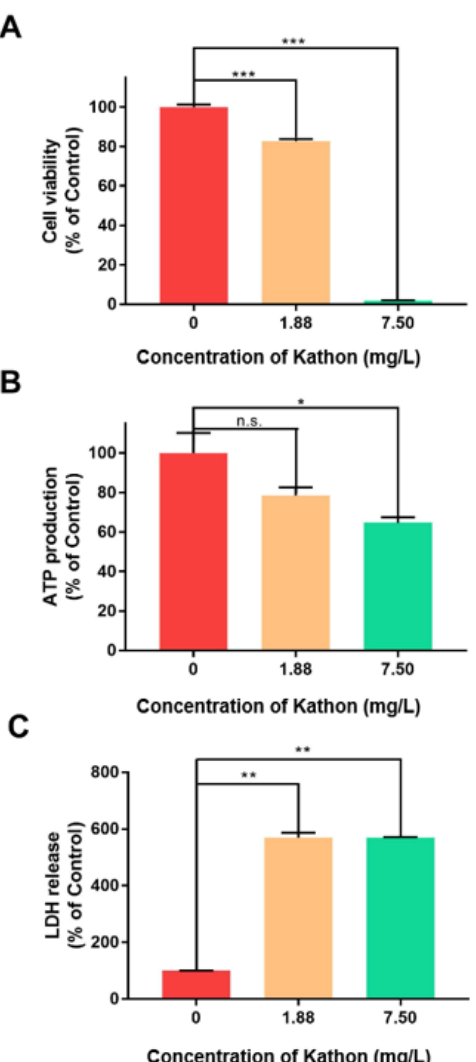
Figure 1. Effects of Kathon on cell viability ( A ), adenosine triphosphate (ATP) production ( B ) and lactate dehydrogenase release ( C ) of S2 cells. Cell viability was determined using the CCK8 assay. ATP production and level of lactate dehydrogenase (LDH) were measured using commercially available kits. All data are presented as mean ± standard error of mean (SEM). * stands for p < 0.05, ** stands for p < 0.01 and *** stands for p < 0.001 (independent t -test). n.s. stands for no significant difference.